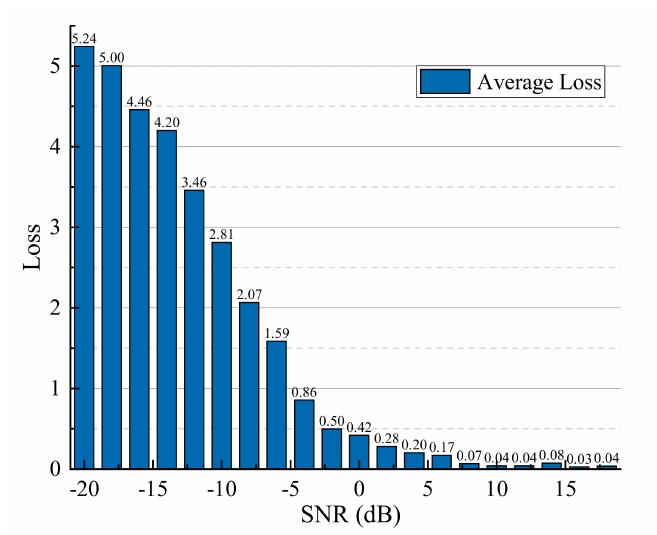
Figure 4. Average loss of actual and predictive modulation type at di ff erent signal-to-noise ratios (SNRs).